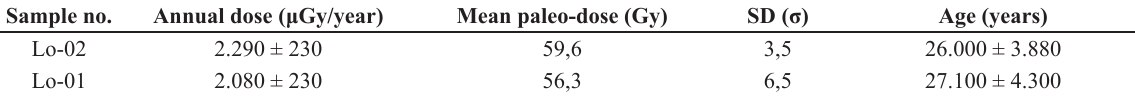
OSL ages of the Cordão